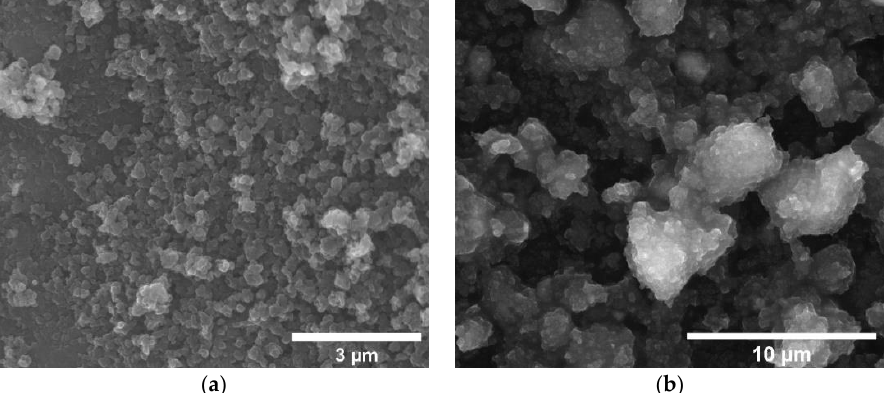
Figure 3. SEM images of: ( a ) RC-600; and ( b ) GRC-600.